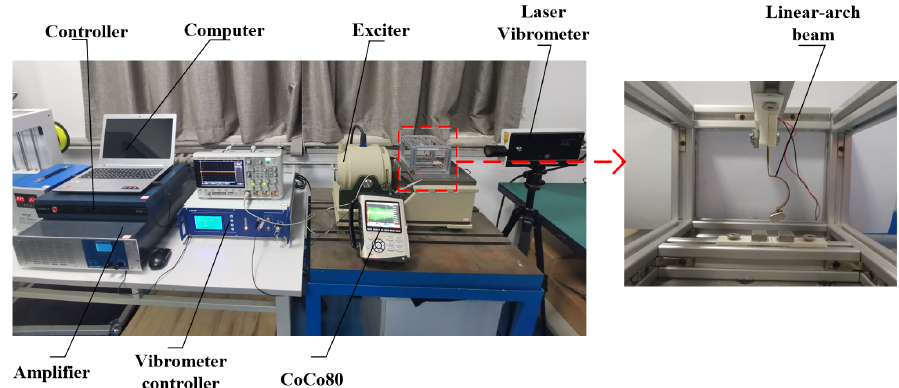
Figure 9. Experimental platform and TPEH.